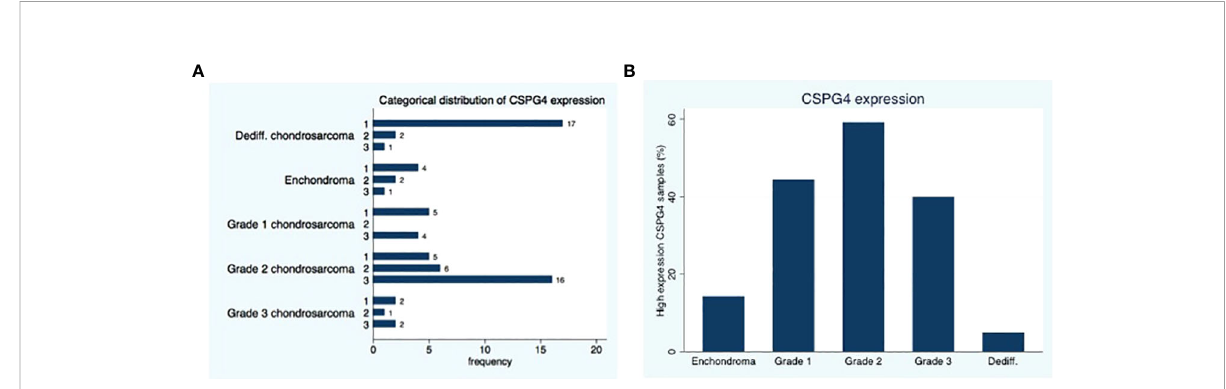
FIGURE 1 Distribution of CSPG4 Expression in Chondrosarcoma. (A) CSPG4 staining using IHC was scored by 2 investigators using a categorical classi fi cation, 1-low expression; 2-medium expression; 3 high-expression. (B) The number of samples within each category that stained positive with high intensity (categorical classi fi cation 3) was plotted as a percentage of the samples in the cohort; the distribution of high intensity CSPG4 positive samples showed a unimodal distribution with the highest percentage observed in grade II. Fisher ’ s exact p =